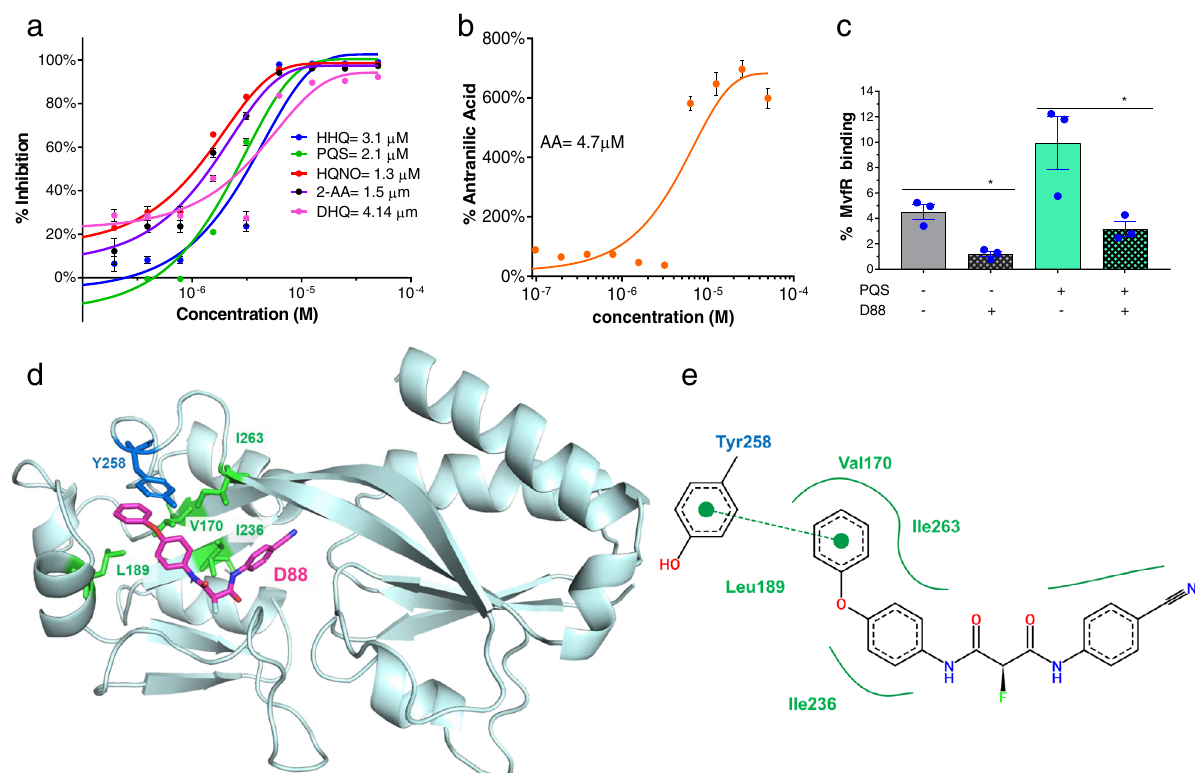
Fig. 5 | IC 50 measurements, in vitro engagement, and molecular docking stu- dies support the prioritization of compound D88. a Dose-dependent inhibition of HHQ,PQS, HQNO,2-AA, and DHQ production wasmeasured in PA14 cultures at OD 600nm =3.0. The cells grown with the compound ’ s vehicle were considered the control. b Dose-dependent production of AA in the presence of D88 in PA14 cul- tures atOD 600nm =3.0. AA isthe primary precursor ofall the MvfR-regulated small molecules assessed in A. GraphPad Prism 9.2.0 software plotted the IC 50 curves against percent inhibition of the HAQs, 2-AA, DHQ, and AA production at each concentration. a , b Data represent the mean value of n =3 biological replicates. Error bars denote ±SEM. c D88 inhibition of MvfR binding to the pqsA promoter. Overnight growncultureof PA14expressing MvfR-VSV-G wasdiluted to OD 600 nm 0.01andgrownat37°CwithandwithoutD88(50 µ M)and/orPQS(38 µ M)untilOD 600 nm 1.0. Thereafter MvfR-DNA complex were cross-linked and isolated via chromatin immunoprecipitation (ChIP). Coprecipitated DNA was puri fi ed and quanti fi ed using quantitative real-time polymerase chain reaction qPCR. MvfR bindingtothe pqsA promoterwascalculatedusingtheinputmethod.Datareprsent